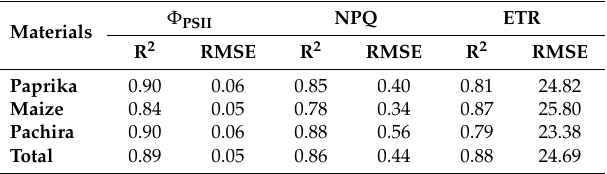
Table 2. Coefficients of determination (R 2 ) and RMSE between the ChlF parameters ( Φ PSII , NPQ, and ETR) measured by the PAM and FLD-LISP methods for the three plant species. This table is a summary of Figure